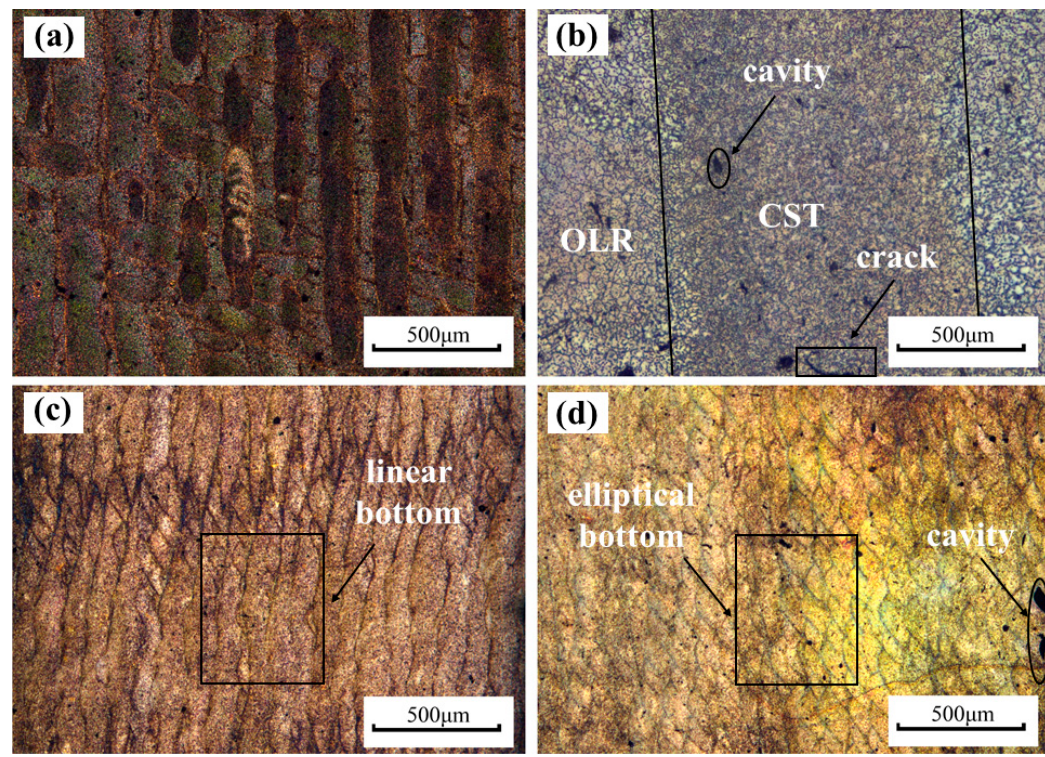
Figure 5. Metallographic microscope photograph of samples at different E v. The cross-section ( a ) and ( b ) at 80 J/mm 3 , the longitudinal section ( c ) at 80 J/mm 3 and ( d ) at 65 J/mm 3 .